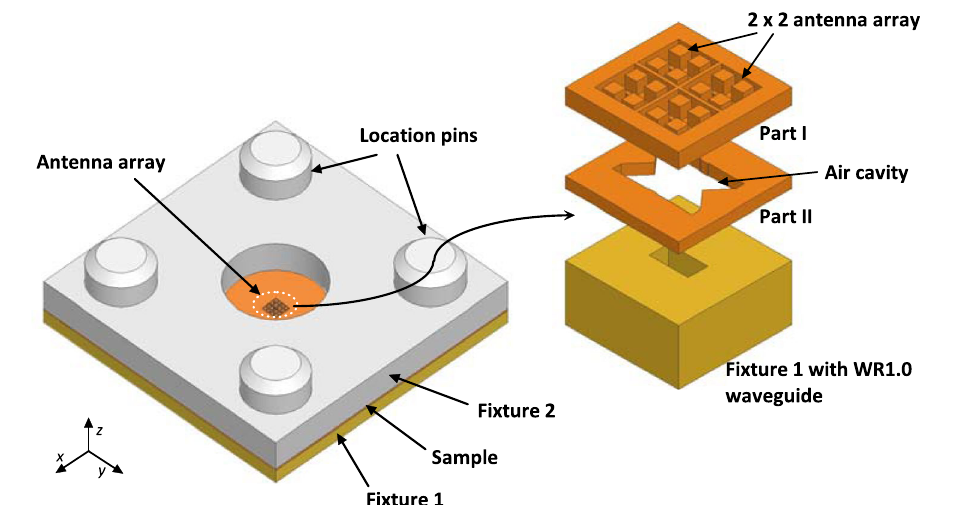
Figure 6. Geometry of the proposed antenna